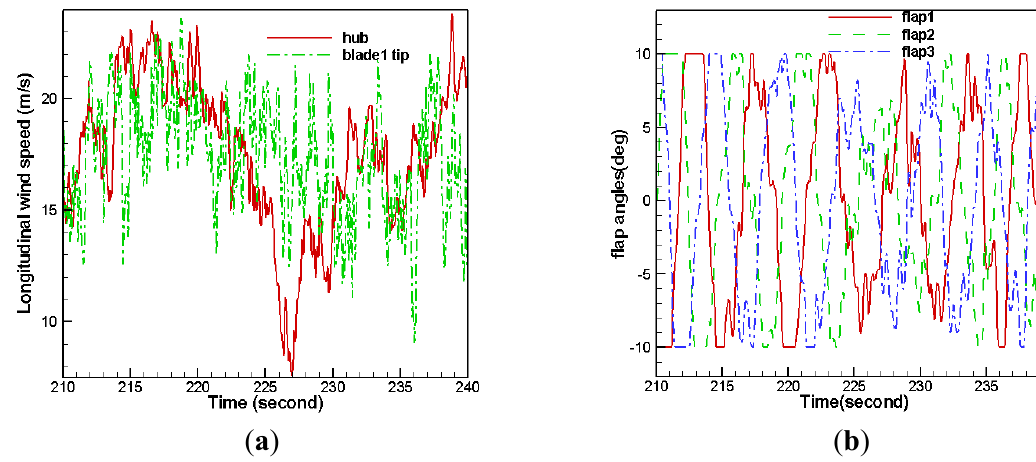
Figure 7. Time and frequency domain results for ETM at 16 m/s: ( a ) longitudinal wind speed; ( b ) deployment angles of three TEFs; ( c ) blade flapwise root moment M flapwise tip deflection B